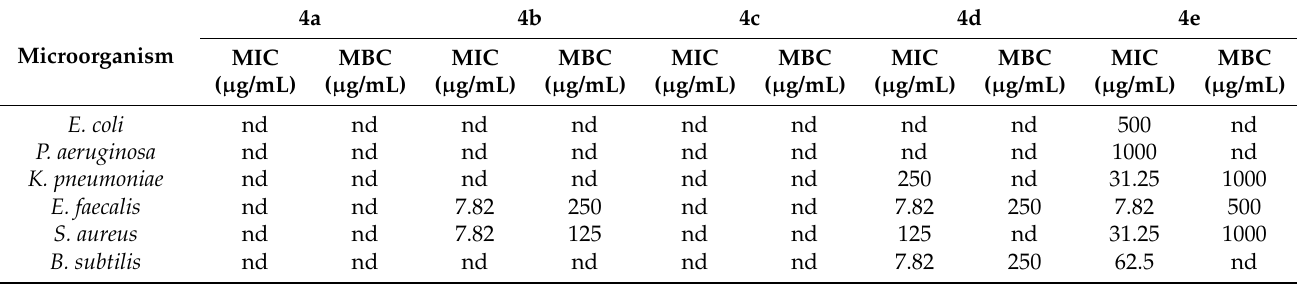
Table 2. MIC ( µ g/mL), MBC ( µ g/mL) of 4a , 4b , 4c , 4d , and 4e towards reference Gram-positive and Gram-negative bacterial strains in dark